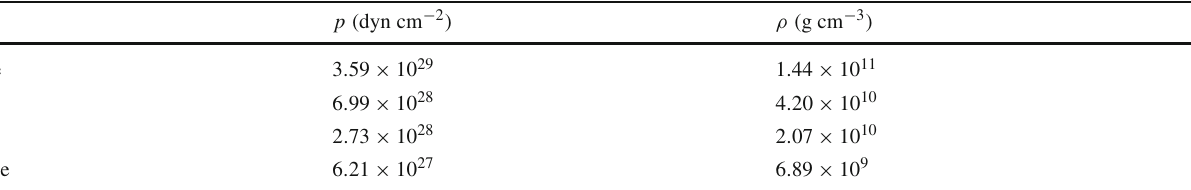
Table 1 Pressure and density threshold for which matter becomes unstable for four elements. The pressure values are taken from Ref. [78]. Considering the threshold pressure within the Hamada–Salpeter EoS, we have the corresponding density threshold